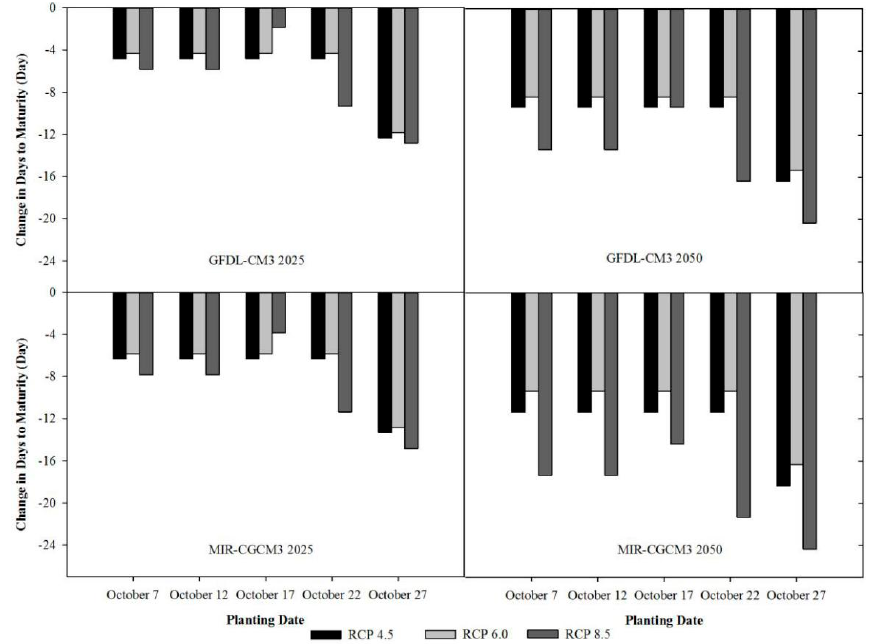
Figure 6. Predicted MDAPS of winter wheat for Guanzhong Plain based on three RCPs under different planting date based on two GCMs in the 2025 and 2050 projections.